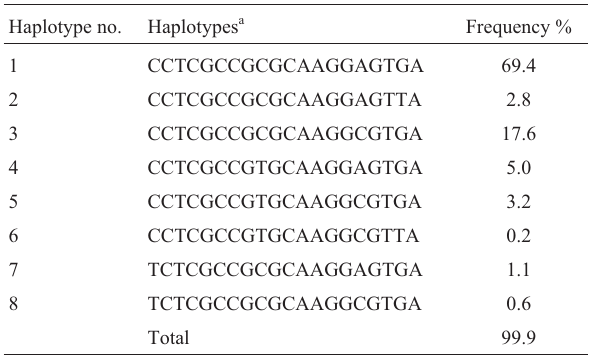
Table 6 - Haplotype structure defined by 20 SNPs in the SLC22A1 gene in the Xhosa population. Haplotype